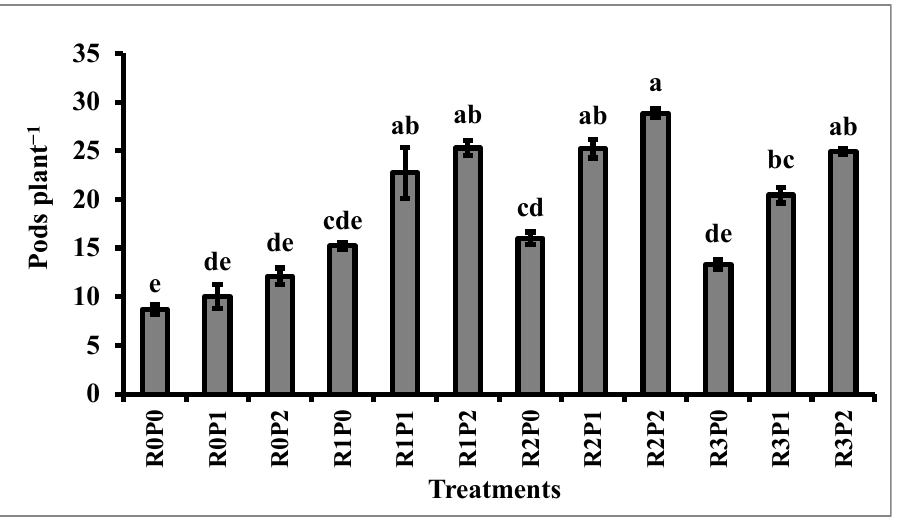
Figure 1. Interaction effect of Rhizobium japonicum and Pseudomonas striata on pods plant − 1 of soybean (mean ± SE, n = 3); R 0 : Control (no nitrogen and R. japonicum ), R 1 : 100% N without R. japonicum , R 2 : 50% N with R. japonicum , R 3 : only R. japonicum inoculant, P 0 : Control (no P and no P. striata ), P 1 : 100% P without P. striata and P 2 : 75% P with P. striata . Mean values sharing similar letters are statistically insignificant. Two-way ANOVA showed a significant interaction ( p ≤ 0.05) between R. japonicum and P. striata